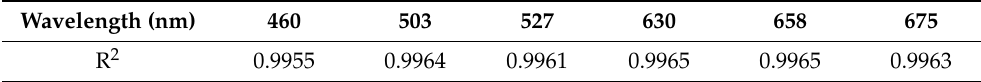
Table 1. Determination coefficients of the measured µ a and the ink volume fraction at six wavelengths.